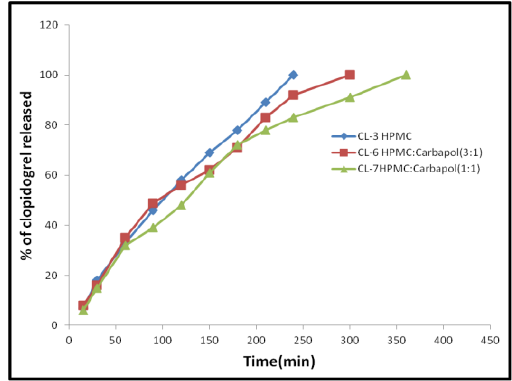
Figure4:The effect of carbapol concentration on the release of clopidogrel in 0.1NHCl and37˚C.